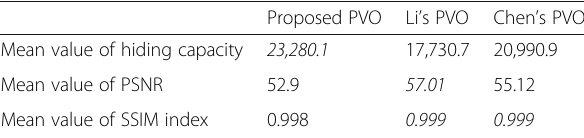
Table 6 Experimental results of the proposed PVO, Li ’ s PVO, and Chen ’ s PVO for BOWS-2 image databases Proposed PVO Li ’ s PVO Chen ’ s PVO Mean value of hiding capacity 23,280.1